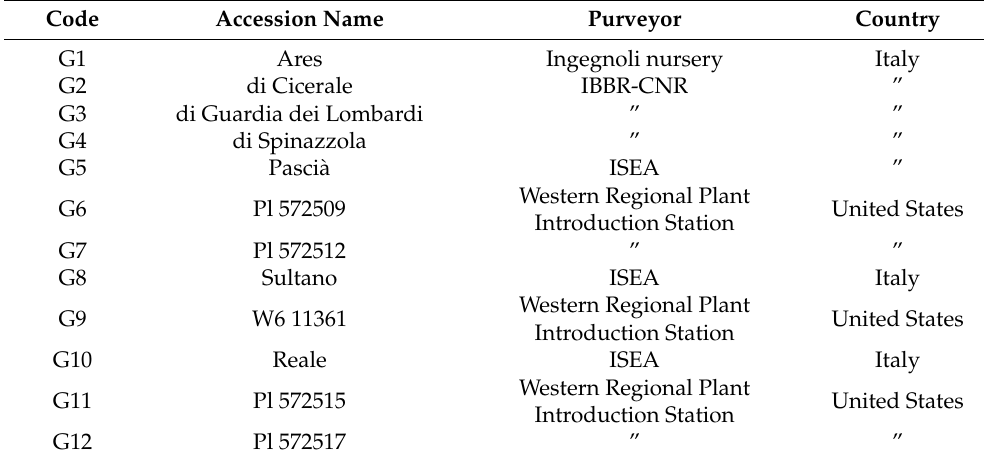
Table 1. Accessions Tested in the Study and their